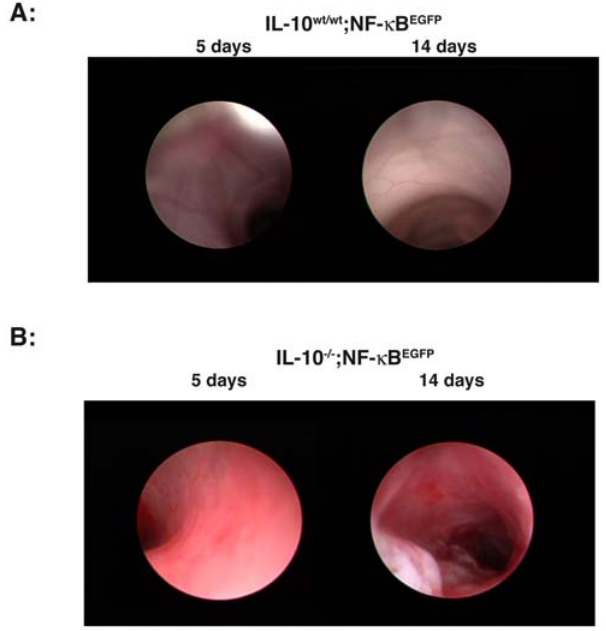
Figure 3. C.jejuni induces rapid and progressive severe colonic inflammation in IL-10 2 / 2 ; NF- k B EGFP mice. Gnotobiotic IL-10 2 / 2 ; NF- k B EGFP mice and control IL-10 wt/wt ; NF- k B EGFP mice were associated with C. jejuni by oral gavage (10 8 cfu/mouse). Inflammation was evaluated macroscopically in vivo using a murine miniature endoscope in IL-10 wt/wt ; NF- k B EGFP control mice (Fig. 2A, n=13) and IL-10 2 / 2 ; NF- k B EGFP mice on day 5 and 14 (Fig. 2B, n=12). The data are representative for two additional experiments.